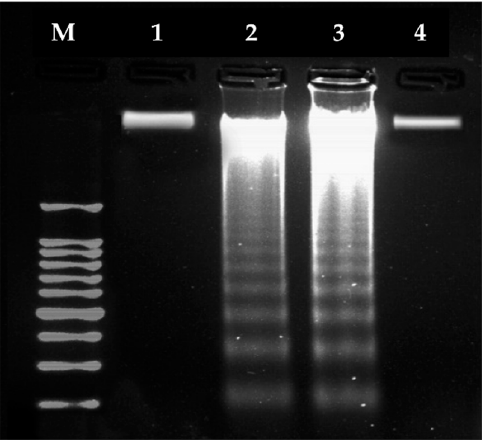
Figure 5. Effects of compound ( 2 ) treatment on DNA fragmentation in MCF7 and Caco2 cells as